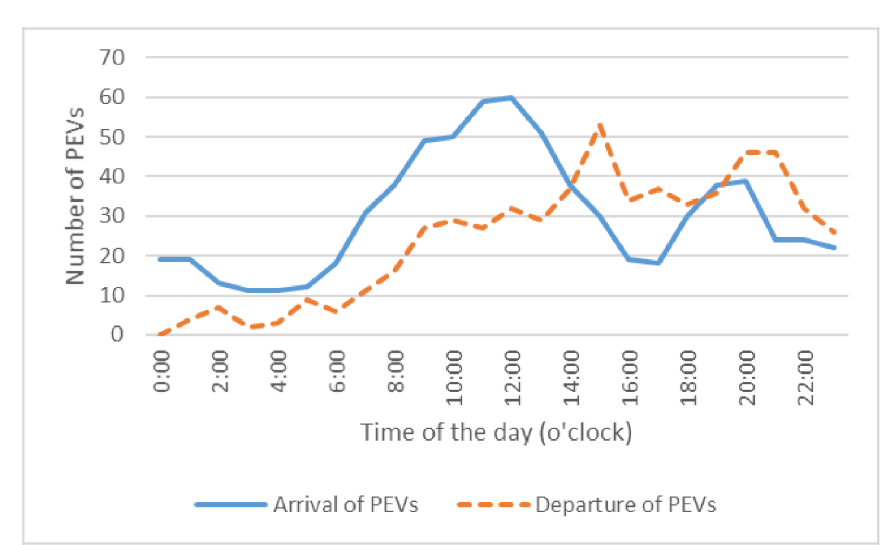
Figure 8. Arrival and departure of PEVs.